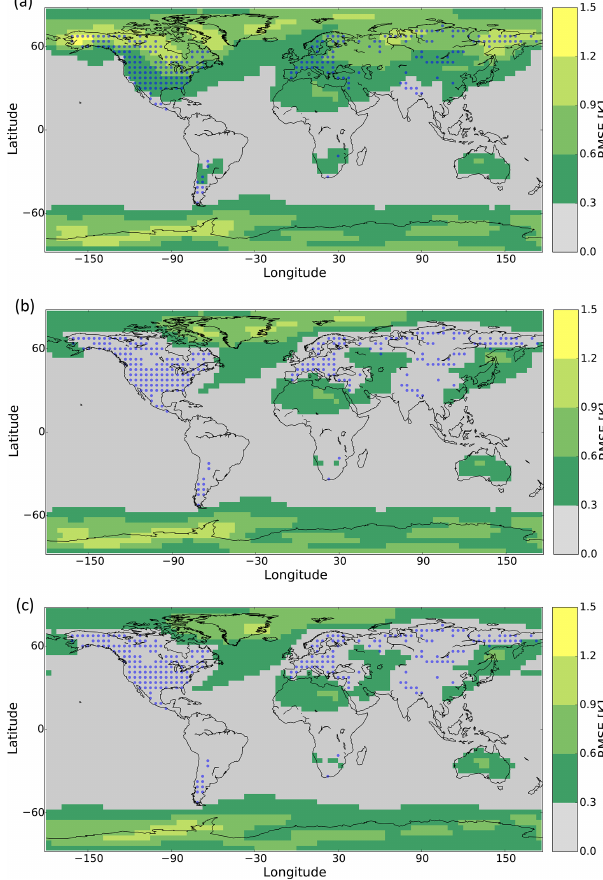
Figure 4. Yearly near-surface temperature RMSE for the ensemble run constrained by VSL-T pseudo-TRW observations. (a) Online forecast quantities, (b) online analysis quantities and (c) off-line analysis